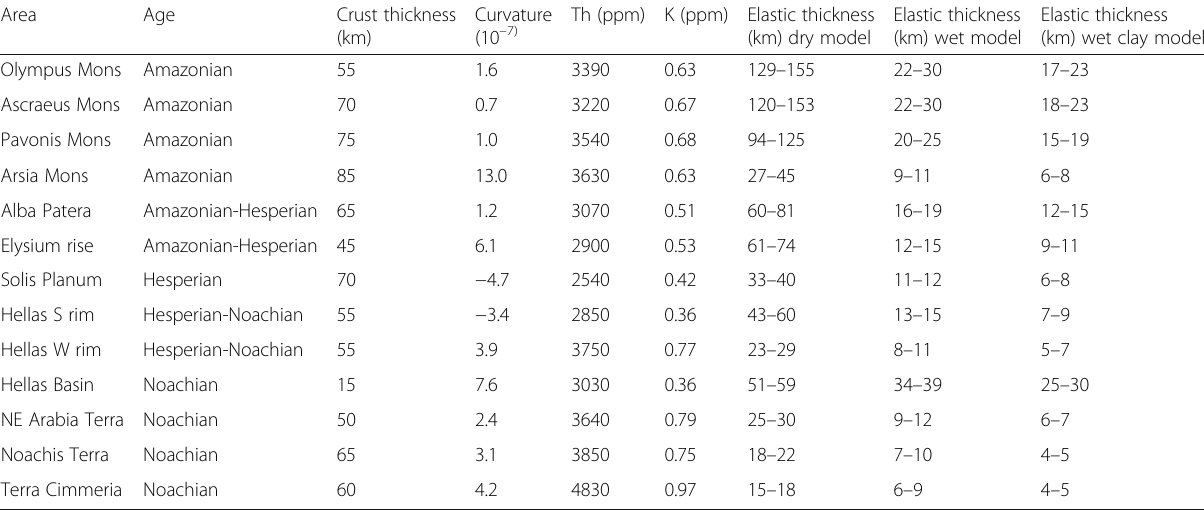
Table 2 Local variation in crustal structure and results of calculated elastic thickness